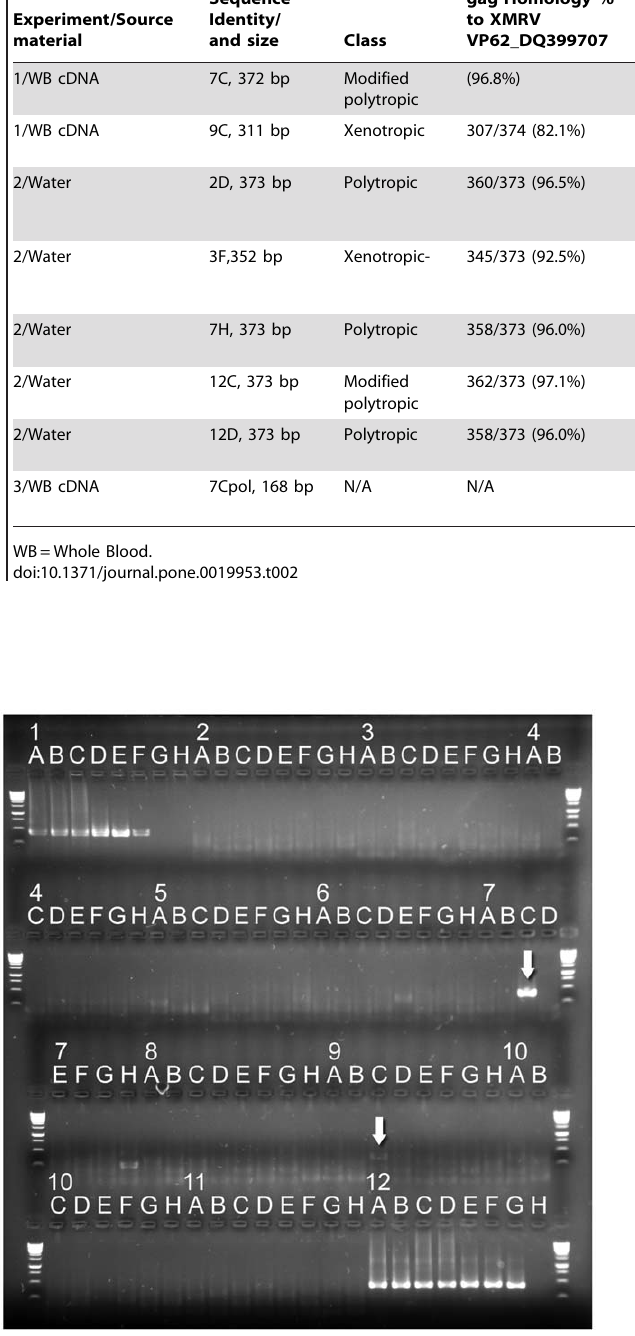
Figure 1. Agarose gel analysis of R2 from experiment 1. gag nested PCR for 80 cDNAs derived from blood donors and controls. Lanes 1A–1H ten fold dilution series of XMRV TCS (Lane 1A equivalent to 5.5 6 10 6 to 5.5 6 10 2 1 cDNA molecules/PCR – determined by Poisson distribution). Lanes 2A–11H 80 cDNAs derived from blood donor whole blood. Lanes 12A–12H ten fold dilution series of Balb/c DNA 10 5 pg to 0.10 pg, negative.